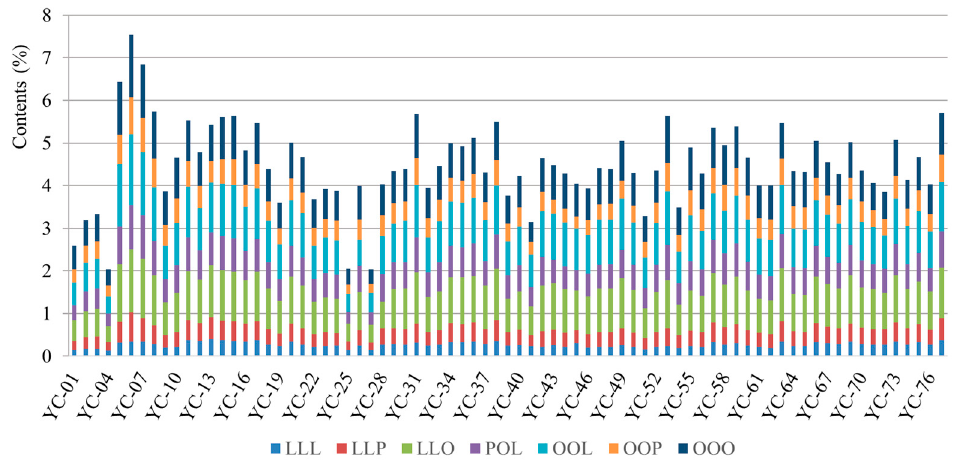
Figure 2. The seven molecular species of TAGs from 77 batches of coix seed (from YC-01 to YC-77). Each color represents different analytes.